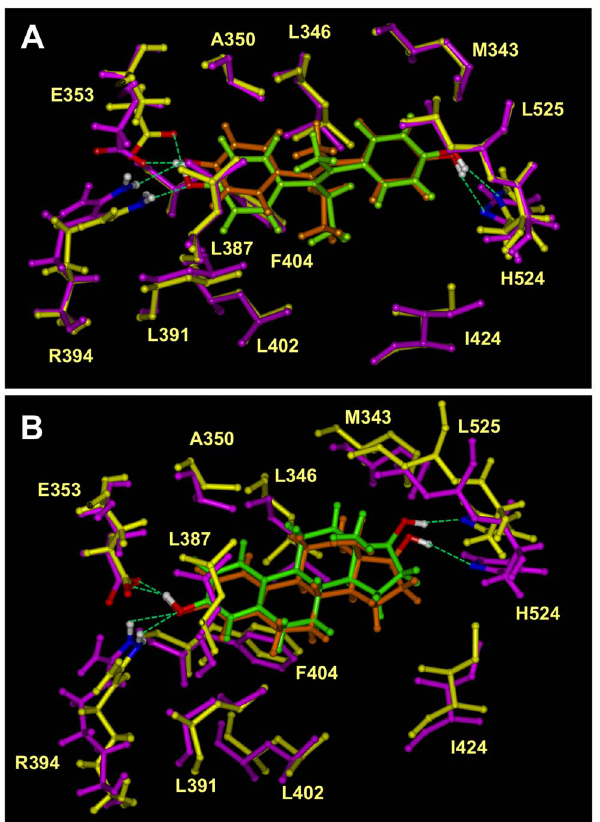
Figure 4. Interactions of A -ring derivatives with ER a LBD determined by the molecular docking method. The green dashes indicate the hydrogen bonds formed. All the structures are shown in ball and stick. The amino acids were colored according to the atom type, i.e. green for carbon, red for oxygen, blue for nitrogen and white for hydrogen. Among the amino acids in the binding site, only E353, R394 and H524 were shown in this figure. E 2 was colored in red; 1- methyl-E 2 and 4-Methyl-E 2 were colored in magenta; 2-OH-E 2 and 4-OH- E 2 were colored in green; 2-Br-E 2 and 4-Br-E 2 were colored in blue; 2- MeO-E 2 and 4-MeO-E 2 were colored in yellow. A . Overlay of all the A - ring derivatives. B . Overlay of E 2 , 1-methyl-E 2 , 2-MeO-E 2 , 2-OH-E 2 and 2- Br-E 2 . C . Overlay of E 2 , 4-methyl-E 2 , 4-MeO-E 2 , 4-OH-E 2 and 4-Br-E 2 .